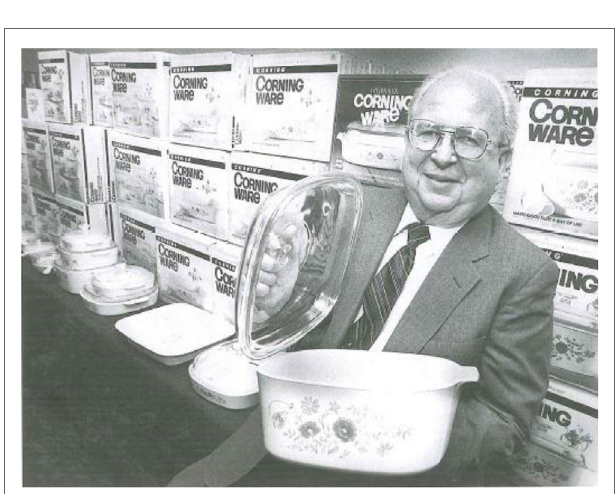
FiGURe 8 | Thermal shock resistance of Corningware ® demonstrated